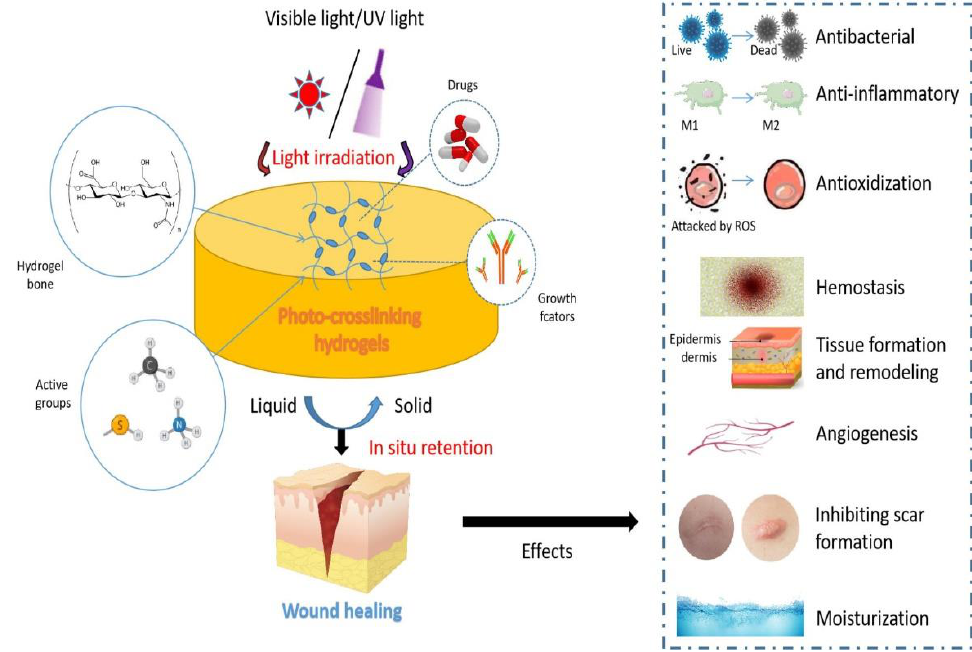
Figure 1. Schematic showing the design and effects of photo-crosslinking hydrogels for wound heal- ing.